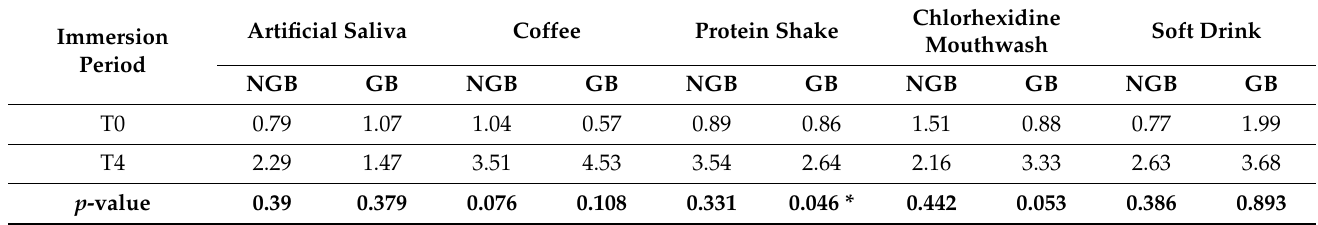
Table 10. Comparison of color change between T0 and T4 for high translucent